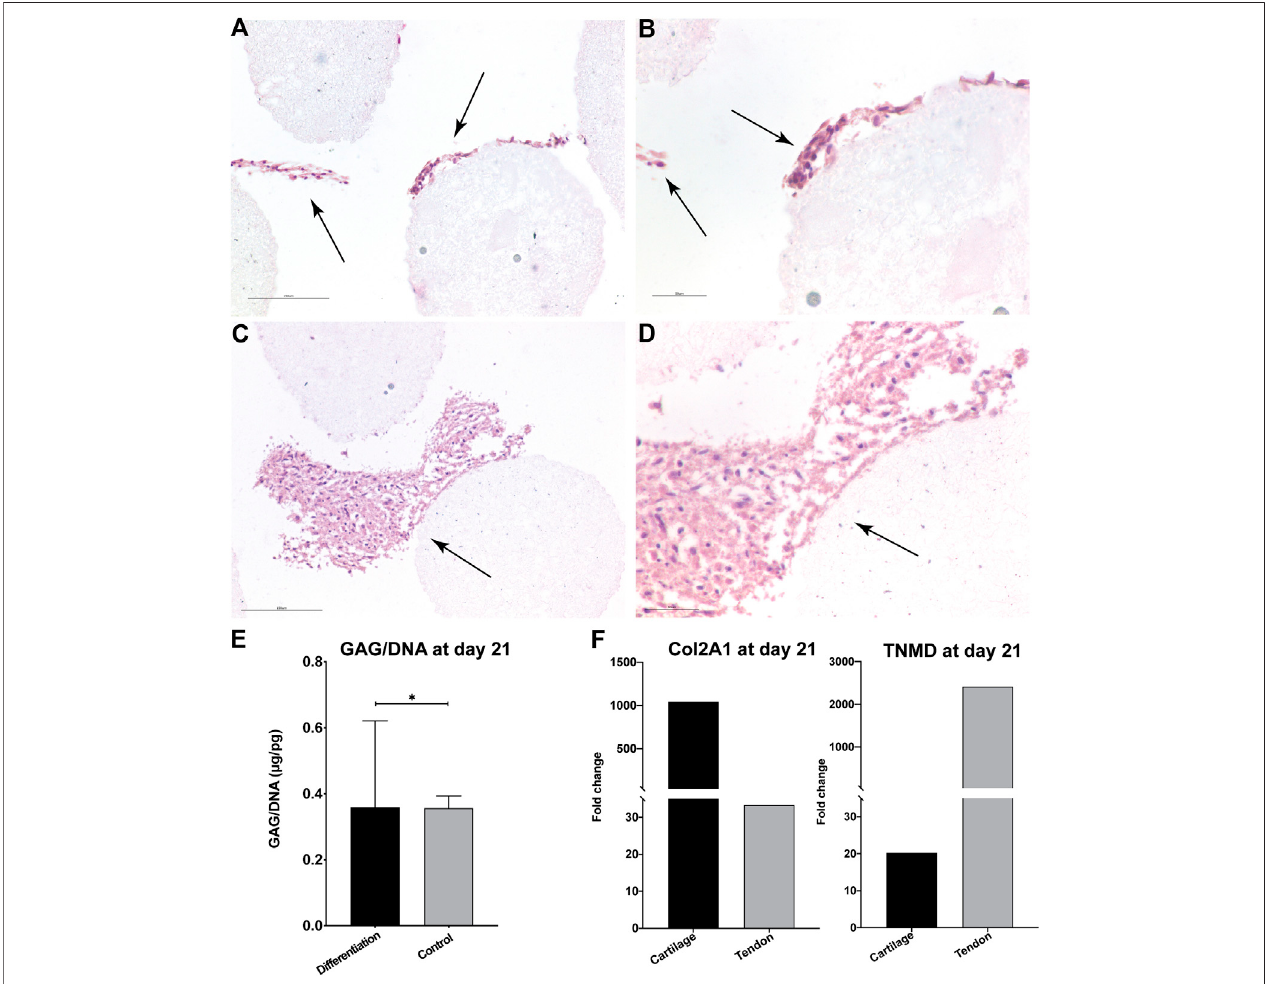
FIGURE4| H&Estainingofthebiphasicconstruct(cartilaginousside)after7 days (A,B) and21 days (C,D) ofcultureattwodifferentmagni fi cations.Blackarrows indicate newly produced extracellular matrix. Scale bar (cid:1) 150 µm (A, C) and 50 µm (B, D) . Overview images of the whole construct are reported in Supplementary FigureS3 (control)and SupplementaryFigureS4 (differentiated).GAGcontentoftheconstructsexpressedasGAG/DNAratioatday21.Datawereanalyzedusingan unpaired t testwithWelch ’ scorrections,* p < 0.05 (E) .RelativegeneexpressionofCOL2A1,andTNMDatday21measuredbyqRT-PCR (F) normalizedtocontrol at the same time